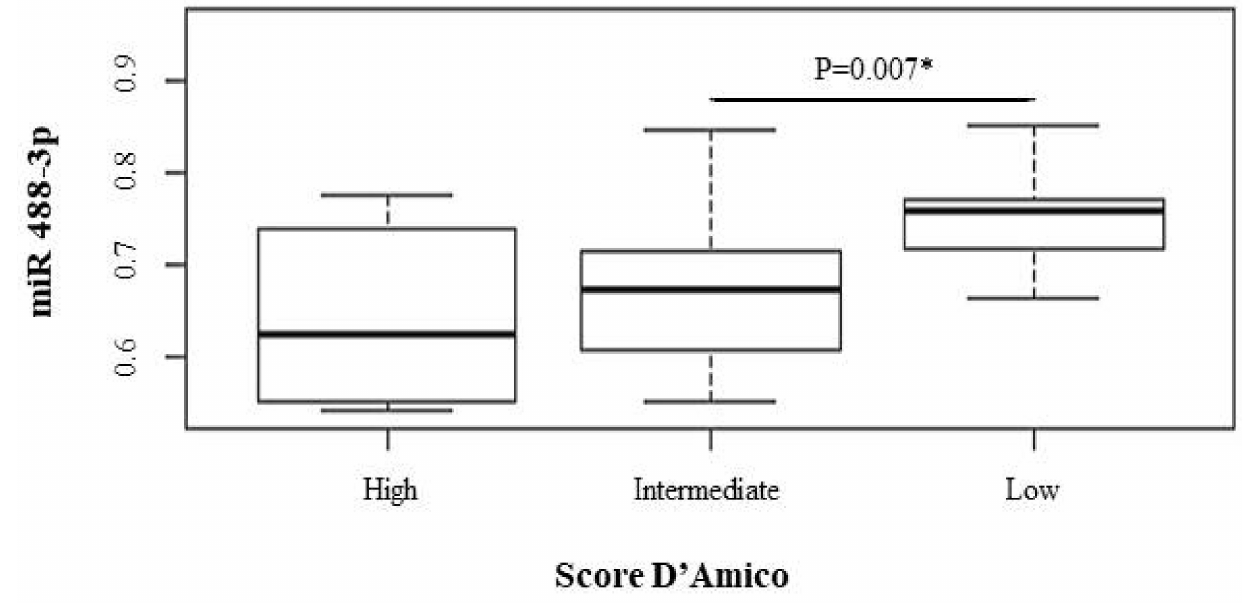
Figure 3. Distribution of Score D’Amico and relative prostate levels of miR488-3p in the CaP patient group. * significative p value (<0.05). All p values were determined using the Mann-Whitney test. The Y axis represents the expression of miRNA by the Western blotting method and the X axis represents the distribution of the sample from the case group according to risk stratification D’Amico Score.